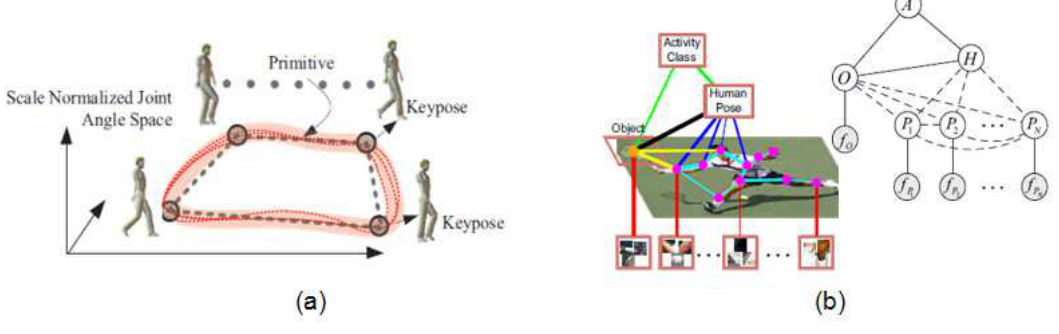
Joint human pose and behavior estimation: ( a ) Different walking examples (curves), the learned models (piecewise lines) and its key poses (frame extracted from [6]); ( b ) Graphical model proposed for object detection (O) and human pose estimation (H) from body part ( P i ) detections, and an image example of a human playing tennis (frame extracted from